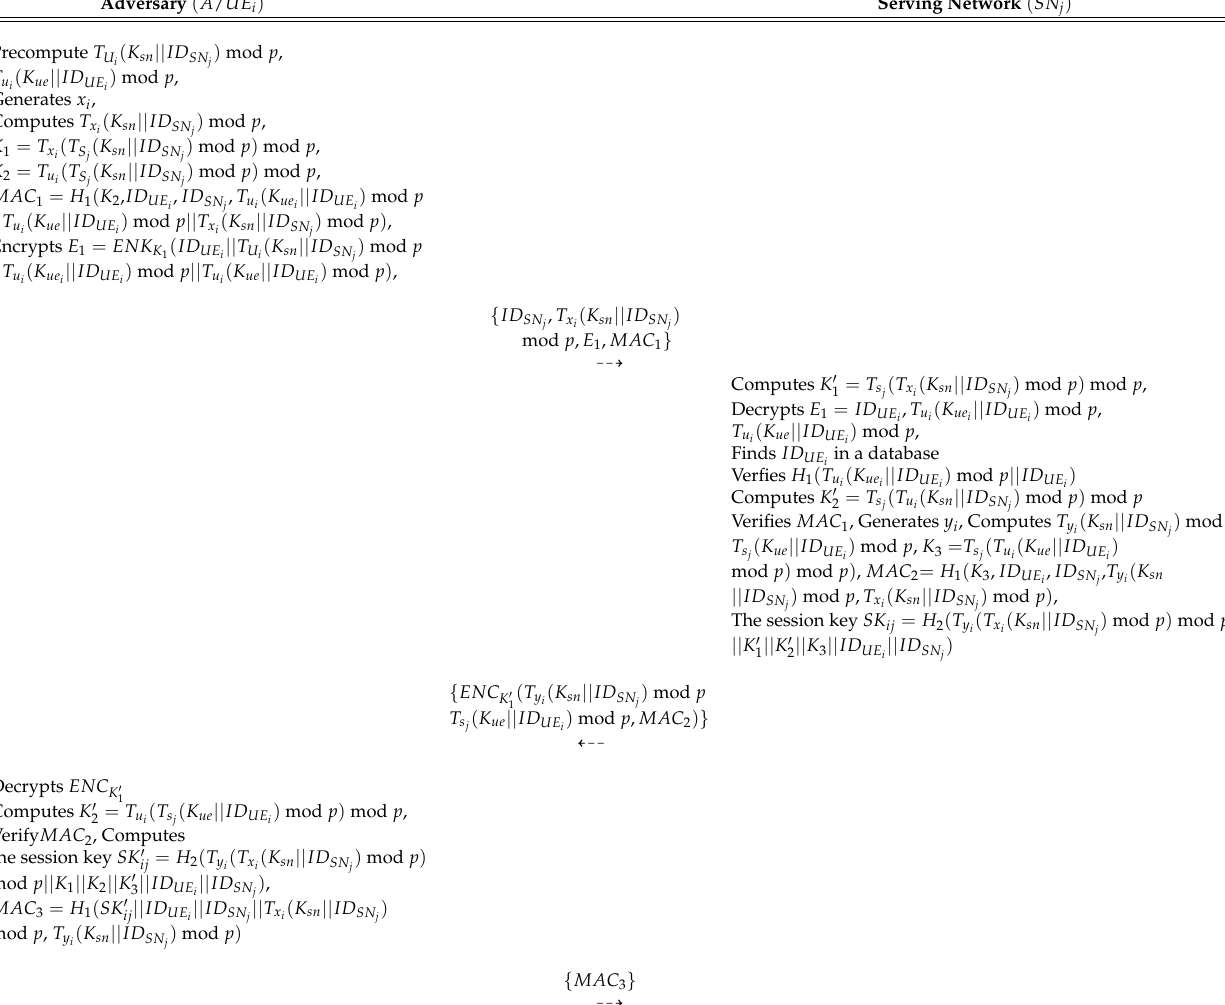
Figure 1. UE impersonation attack in Cao et al.’s